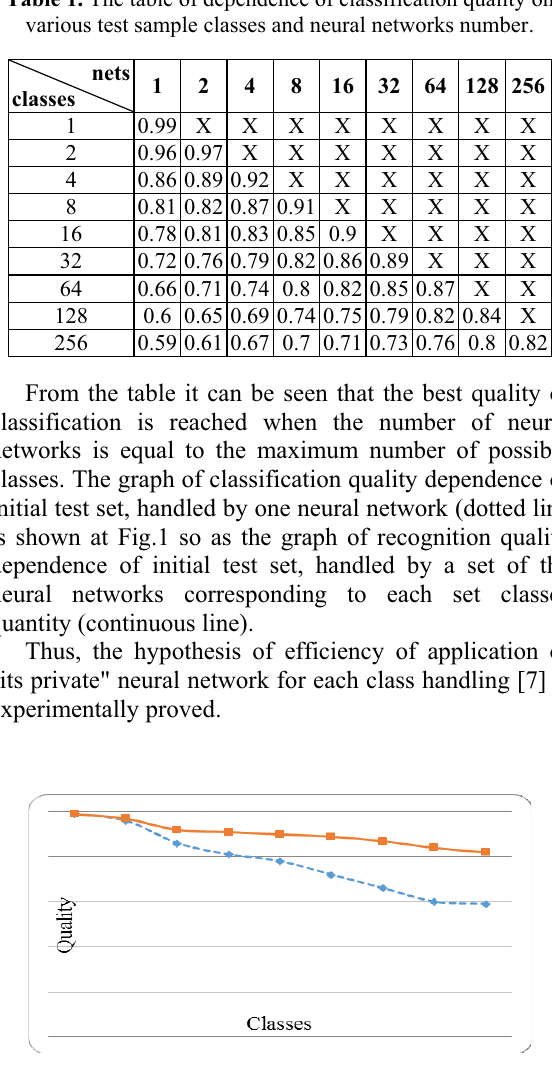
Figure 1. Classification quality dependence of initial test set, handled by one neural network and by a set of the neural